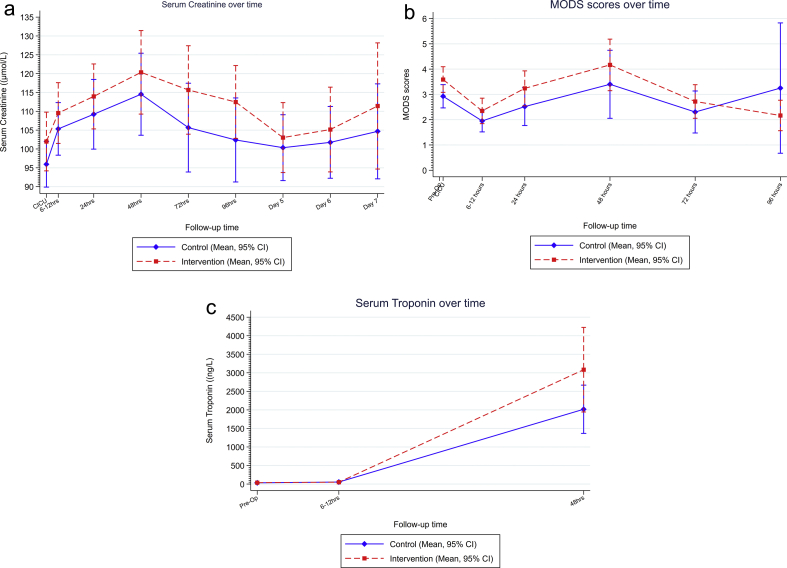
(a) Serum creatinine values. Data expressed as mean (standard deviation [sd]). (b) Multiple organ dysfunction scores. Data expressed as (sd). (c) Serum troponin. Data expressed as mean (sd). CI, confidence interval; CICU, cardiac ICU.